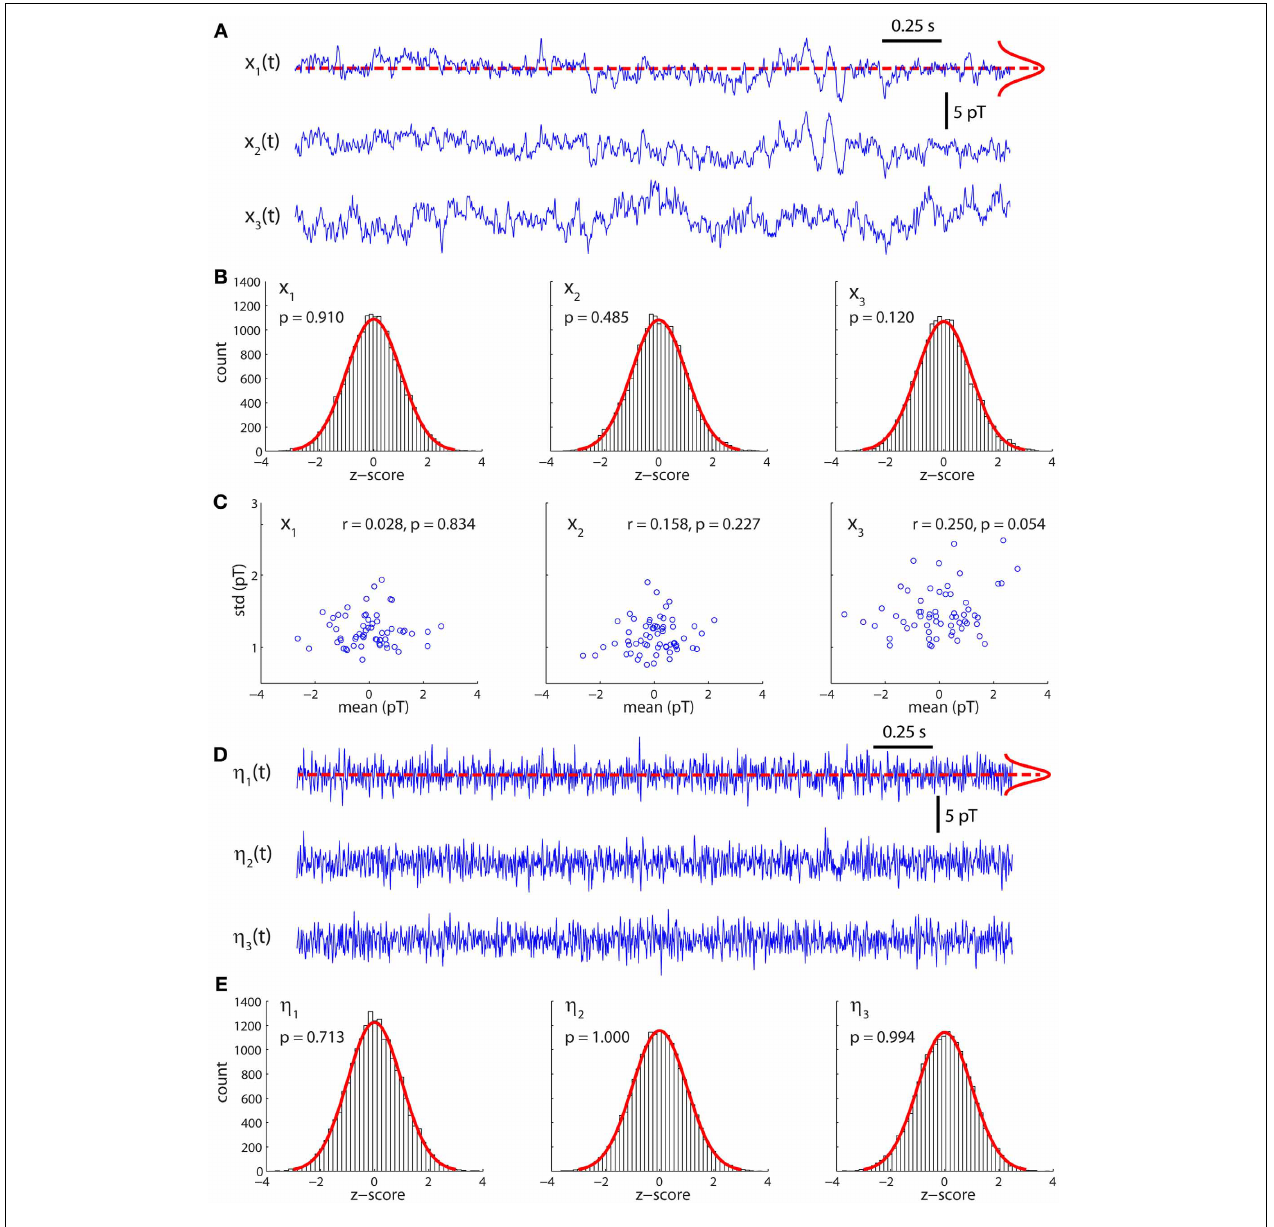
FIGURE 2 | Activity fluctuations at rest are normally distributed. (A) Recordings of ongoing activity (3s long) from three arbitrary sensors in a control subject. (B) Activity fluctuations have zero mean and are normally distributed. The histograms were built from segments of 30 s. (C) Over